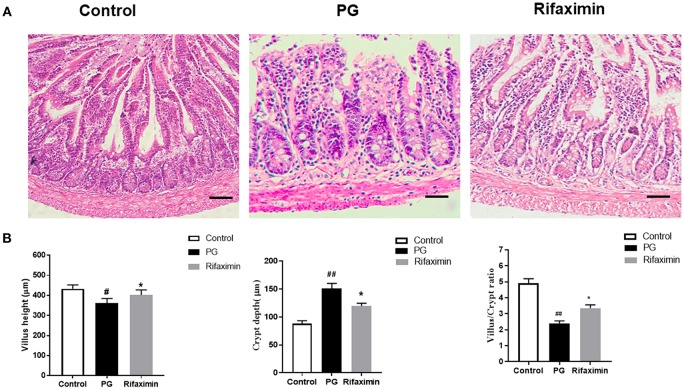
Rifaximin reduces ileum histological alterations in AS mice. (A) Ileum excised at week 14 were stained with H&E (Scale bar is 50μm). (B) Statistic data of villus height, crypt depth, and villus/crypt ratio. Data are expressed as means ± standard deviation from 6 mice per group (#P < 0.05 and ##P < 0.01 vs. control; *P < 0.05 vs. PG alone).